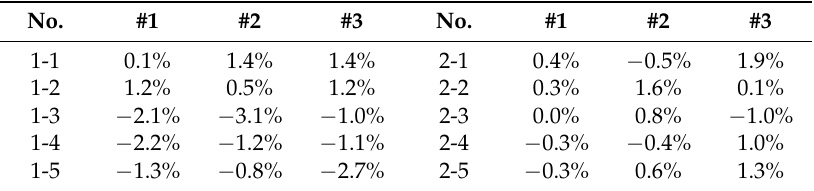
Table 1. Relative error between the observed and calculated accumulative discharges at each cross section in man-made flood events.